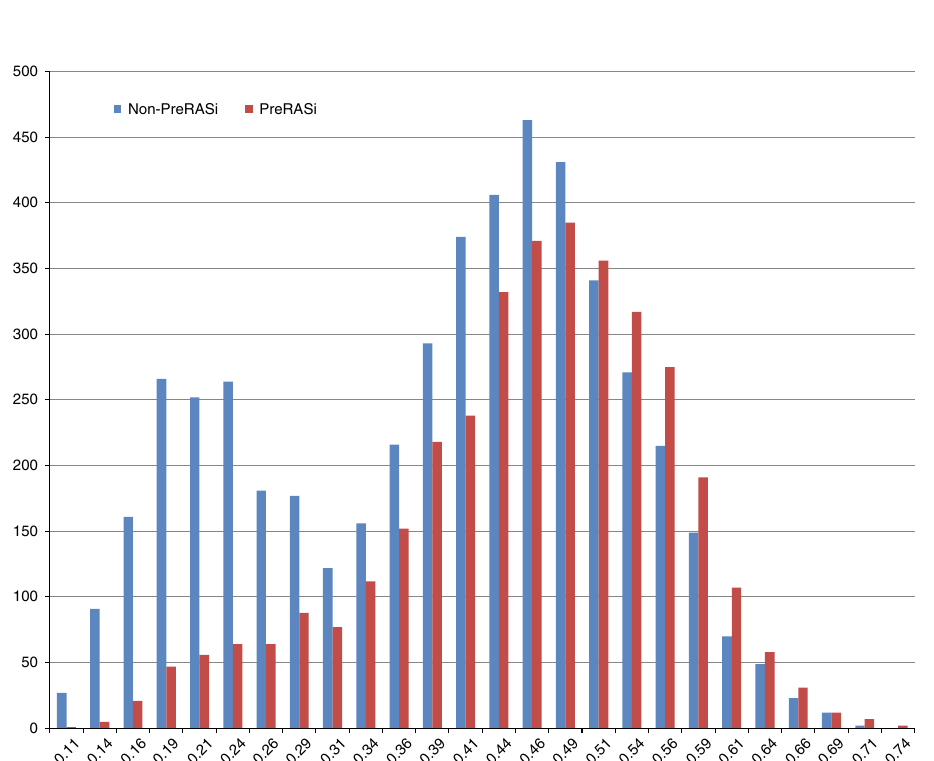
Fig. 2 Distribution of propensity scores for preoperative RASi (PreRASi) in the patient populations (y-axis). The propensity score (x-axis) for PreRASi is the probability given baseline variables that any patient in either group would be selected for